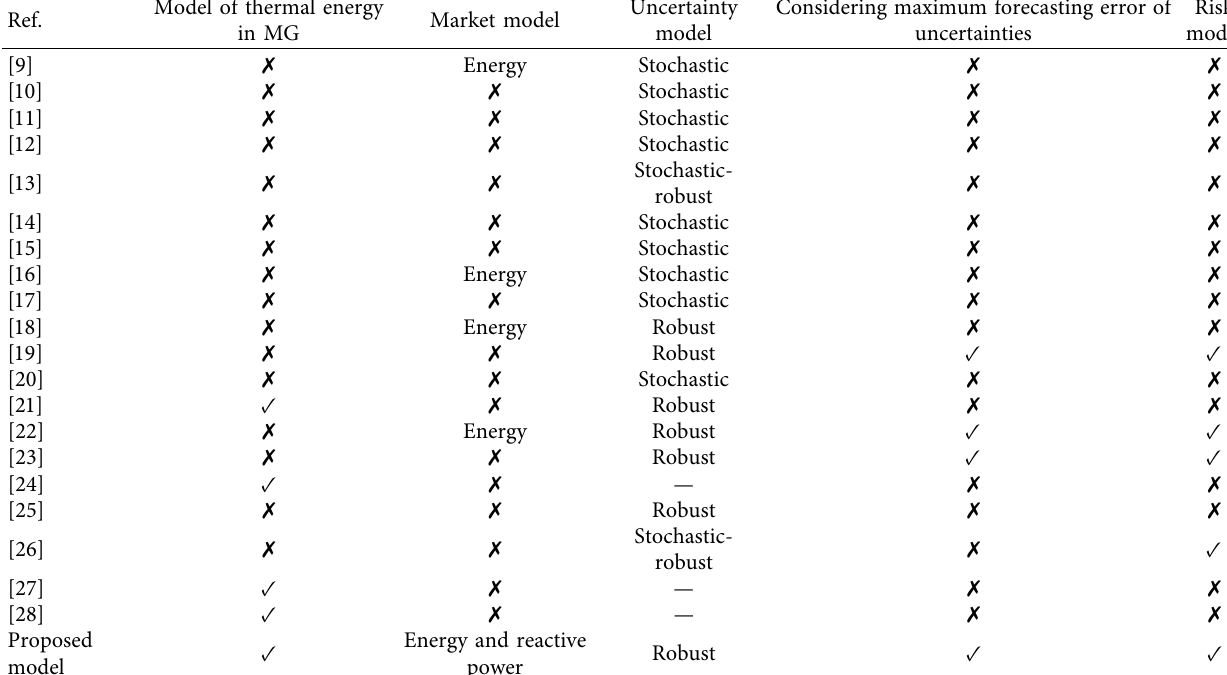
Table 1: Taxonomy of recent research works.